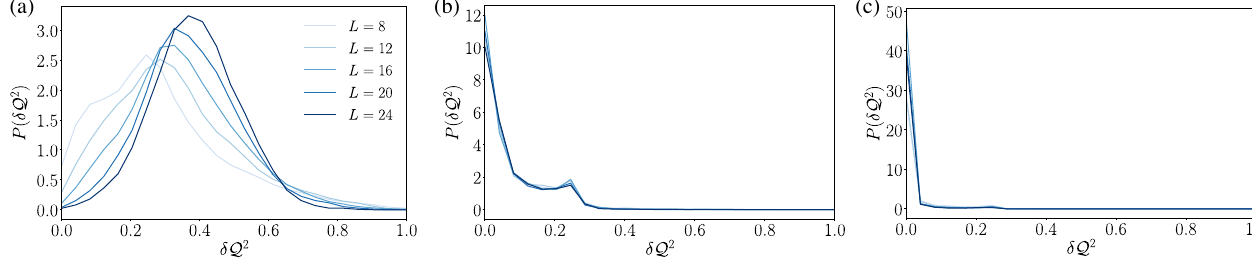
FIG. 15. Charge variance distribution in the qubit model. Distribution of the charge variance at t=L ¼ 4 (a) in the charge-fuzzy phase p ¼ 0 . 05 , (b) near the critical point p ¼ 0 . 10 , and (c) in the charge-sharp phase p ¼ 0 . 14